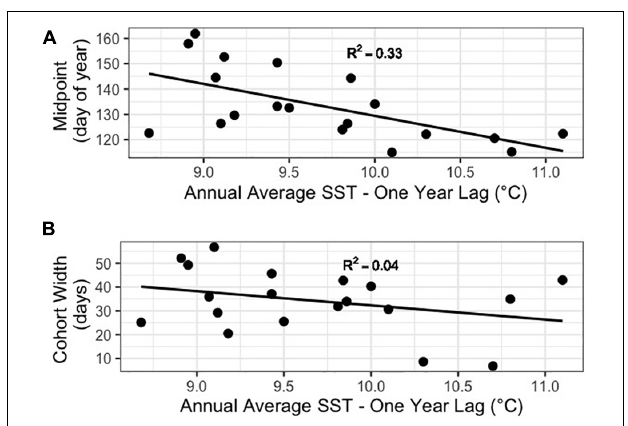
FIGURE 5 | (A) Plot of cohort abundance midpoint against one-year lag mean HadISST. (B) Plot of cohort width against one-year lag mean HadISST.